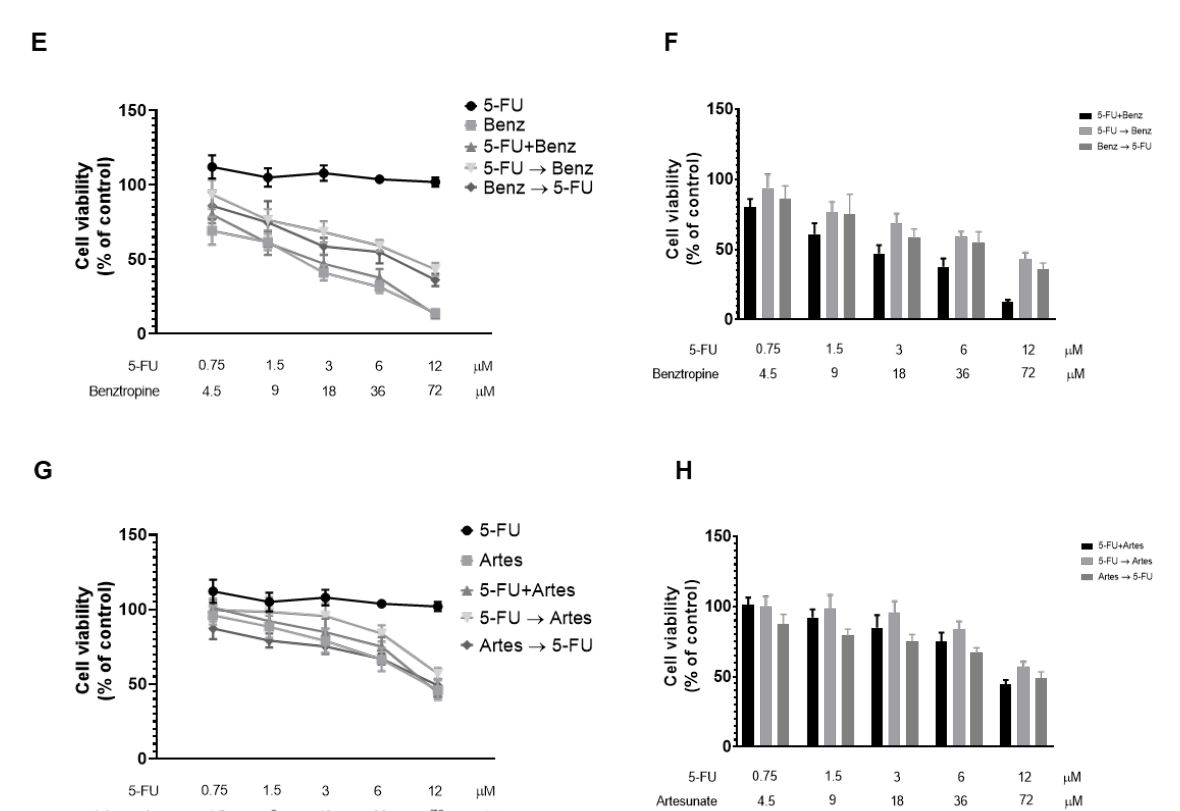
Figure 12. HT-29 cells were exposed to sequential 5-FU and ( A , B ) fluphenazine ( C , D ) fluoxetine ( E , F ) benztropine and ( G , H ) artesunate using constant ratios of the IC 50 dose. Values are expressed in percentage of control and represent means ± SEM. Each experiment was done three times independently ( n = 3).